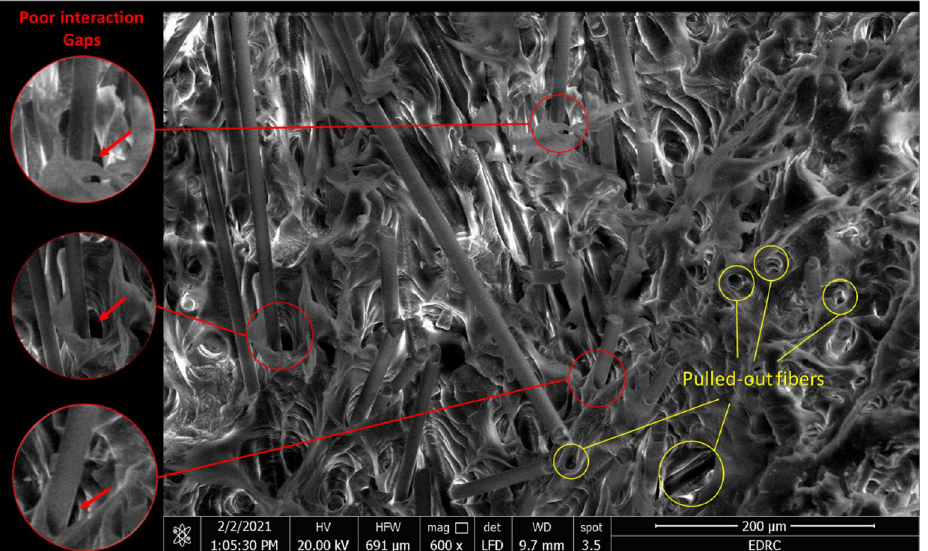
Figure 6. SEM of a fractured 30 wt% GFRPP specimen out of bearing strength